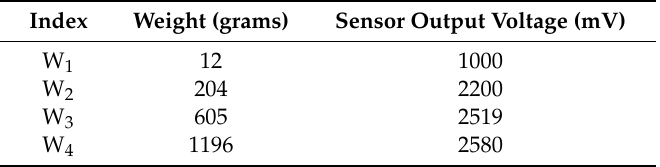
Table 5. Analog force sensors output voltage (mV) in function of four known weights (grams). Values achieved with a fixed resistor of 5.1 k Ω